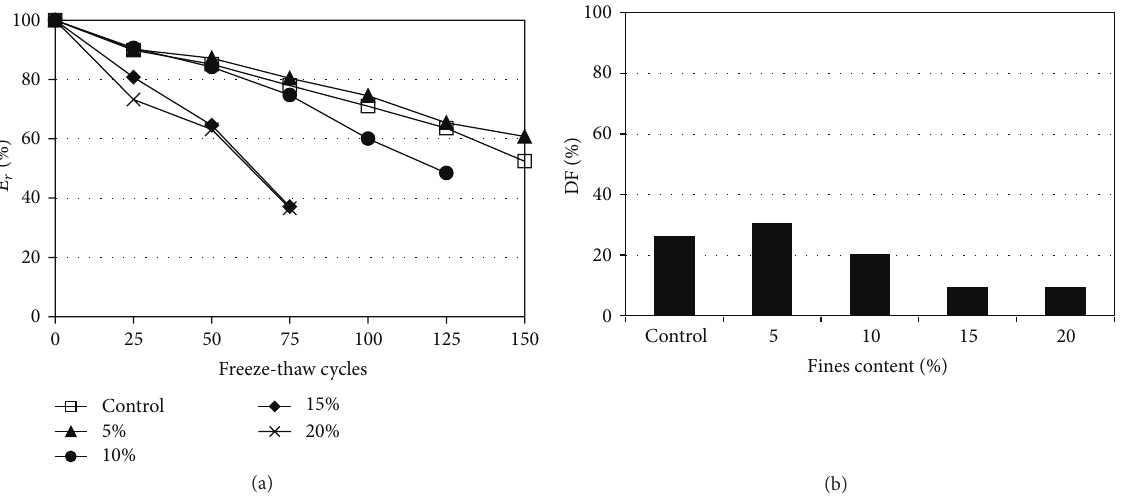
Figure 1: Effect of fines content on frost durability of C30 CSC: (a) 𝐸 𝑟 . (b) DF.